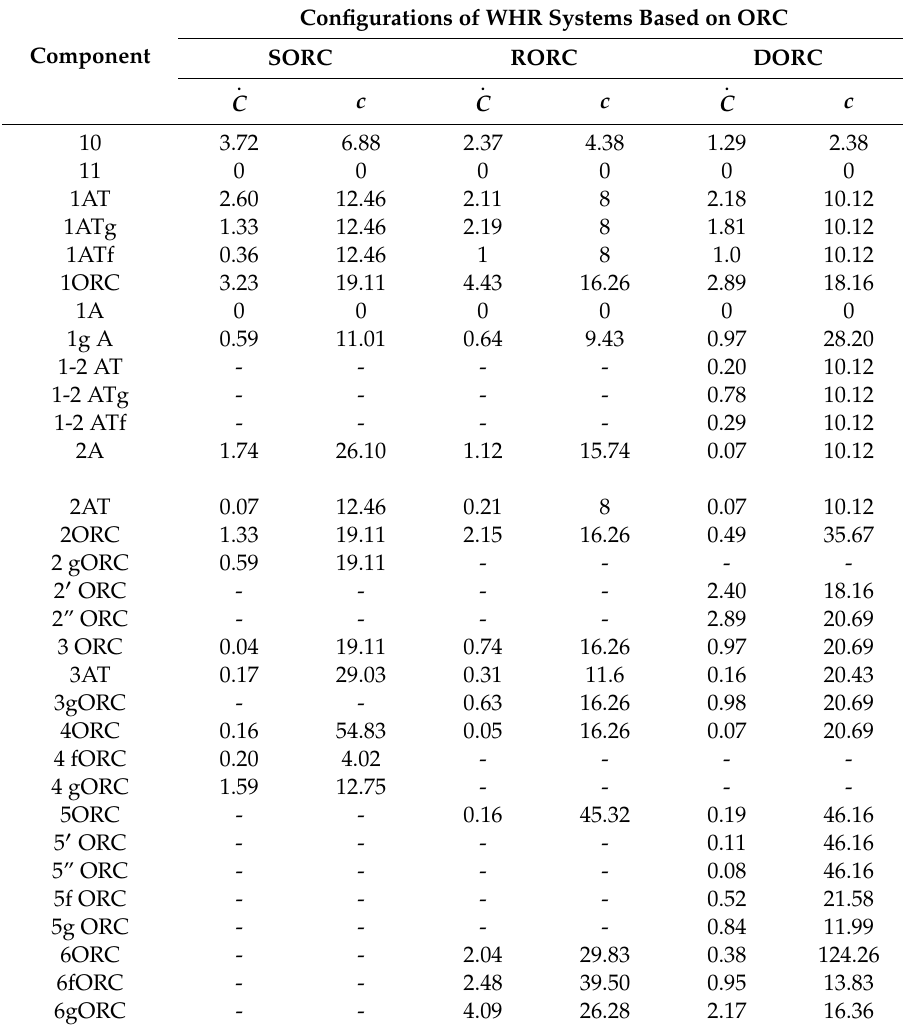
. C (10 − 3 USD / s) and costs per unit of exergy c (USD / Table 4. Cost rates